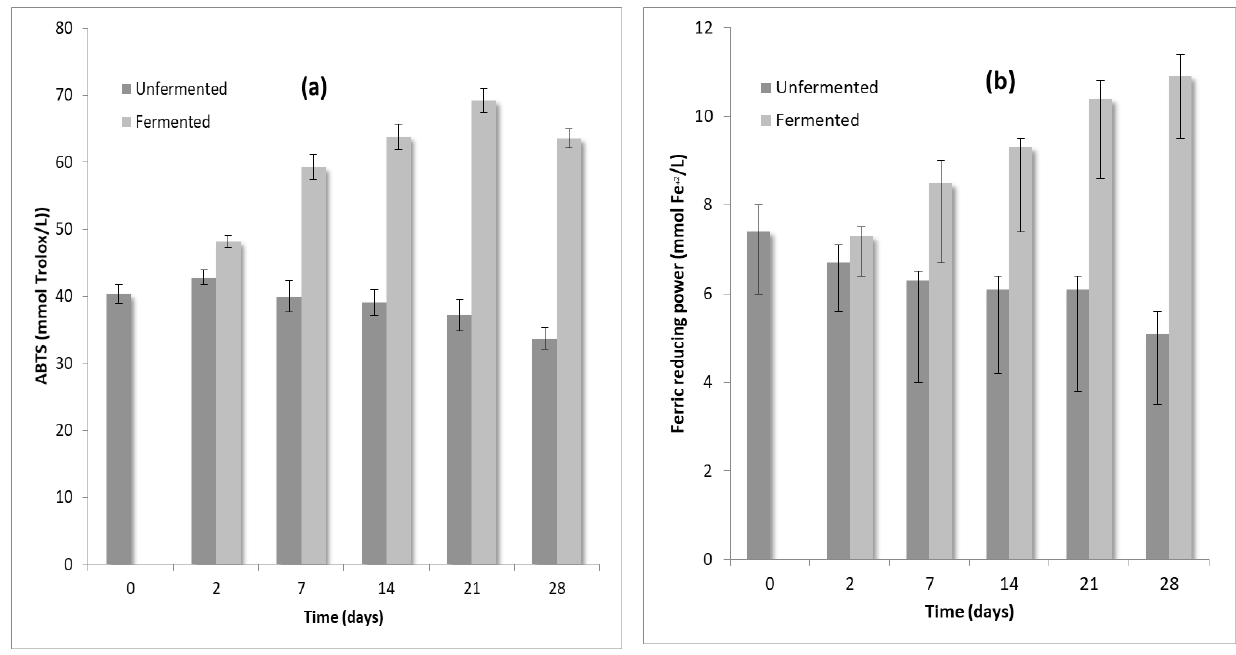
Figure 1. ABTS•+ radical scavenging capacity (a) and ferric reducing power (b) of unfermented and fermented chokeberry Figure 1. ABTS • + radical scavenging capacity ( a ) and ferric reducing power ( b ) of unfermented and fermented chokeberry juice at 30 °C for 48 h and during storage (4 °C for 4 weeks). juice at 30 ◦ C for 48 h and during storage (4 ◦ C for 4